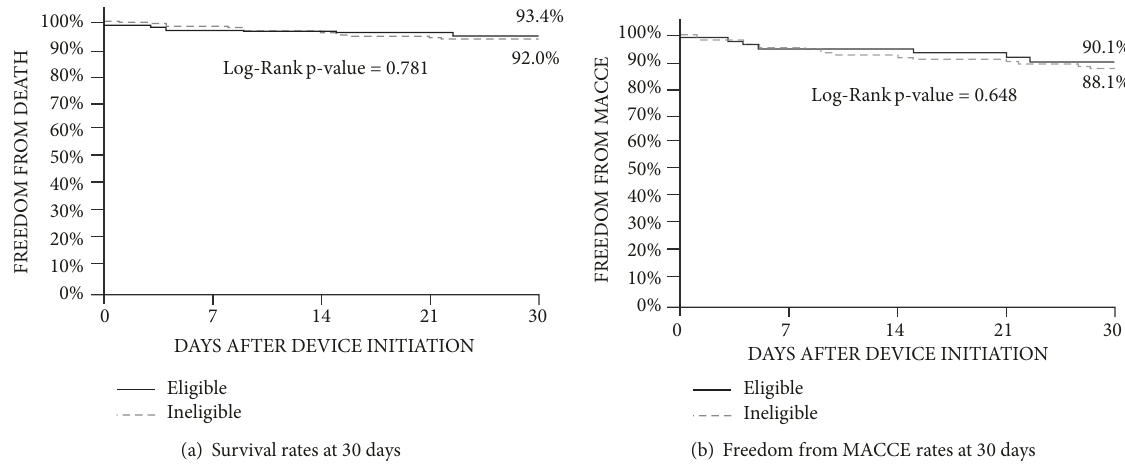
(b) Freedom from MACCE rates at 30 days Figure 1: Kaplan-Meier analysis of estimated 30-day survival rate and freedom from MACCE rate. MACCE: major adverse cardiac and cerebrovascular events (death, stroke, myocardial infarction, and repeat revascularization).